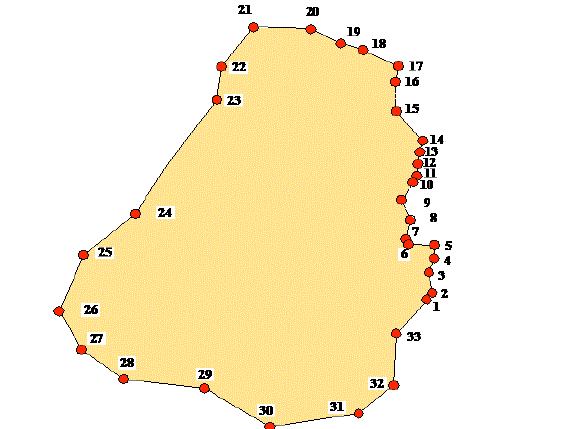
Figure 3: original boundary coordinates provided by the PDTRA.